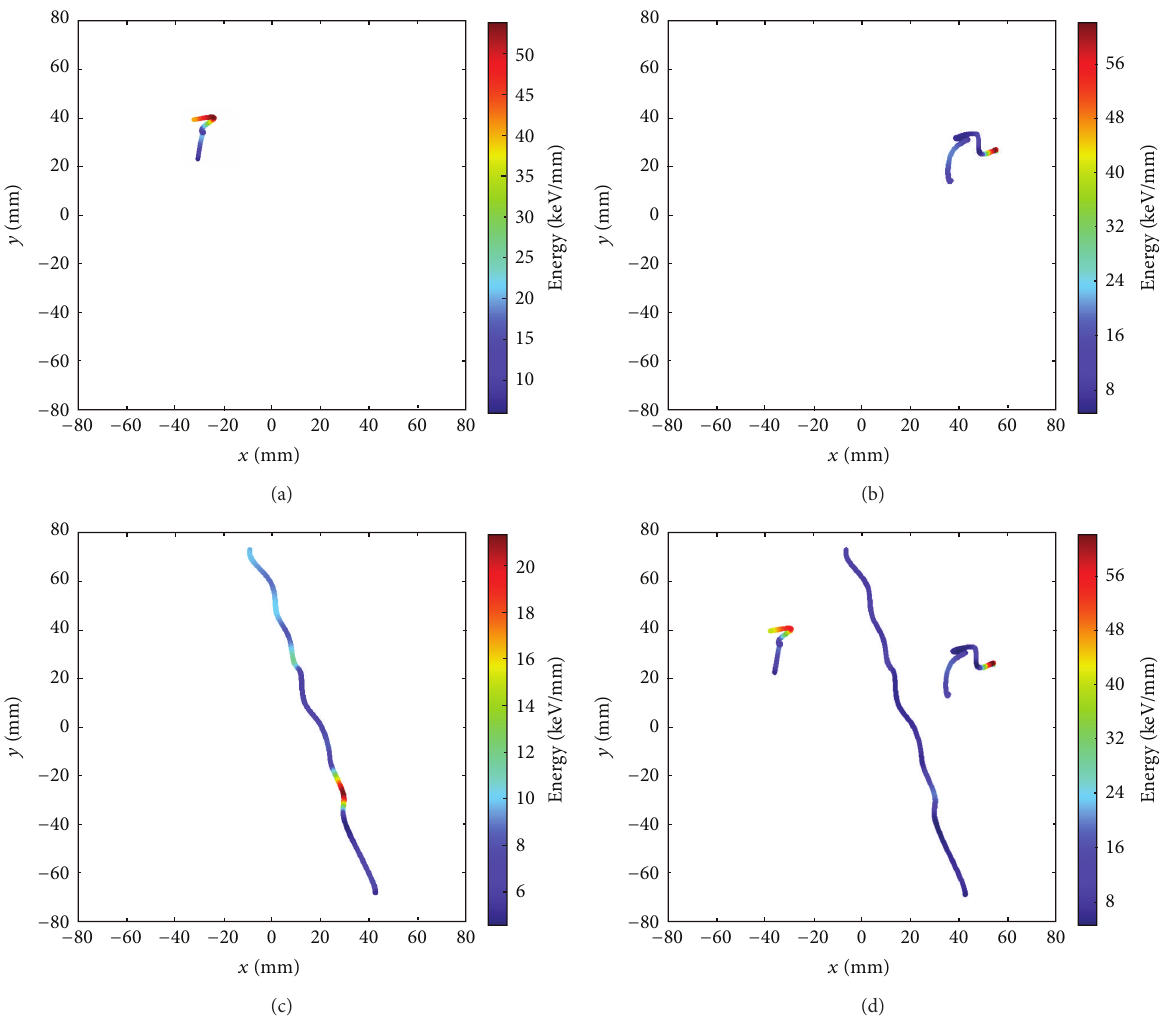
Figure 29: Examples of 22 Na (a), 137 Cs (b), and muon (c) track 𝑥𝑦 plane projections. (d) The three events with the same energy scale. The endpoint of the electron is clearly visible for 22 Na and 137 Cs while the energy deposition for the muon is almost constant. Tracks reconstructed from NEXT-DEMO data